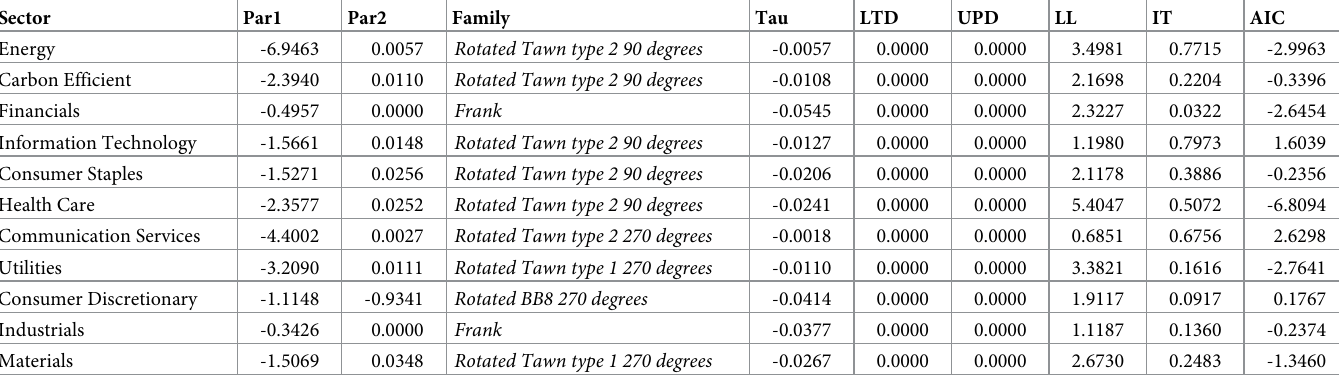
Table 5. Copula results during the EBOV